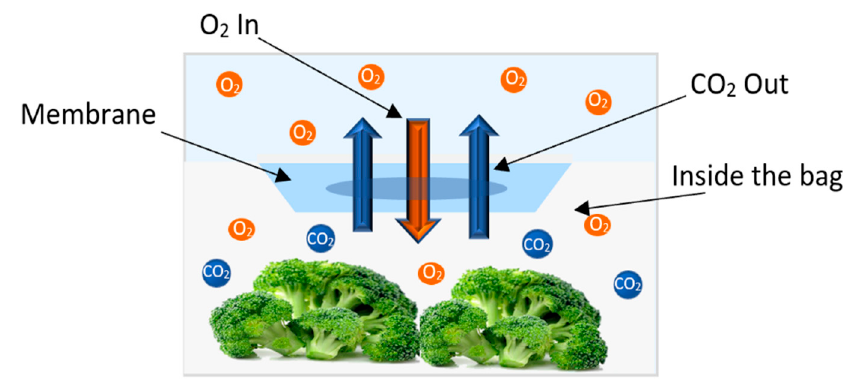
Figure 18. Working principle of temperature compensating films.